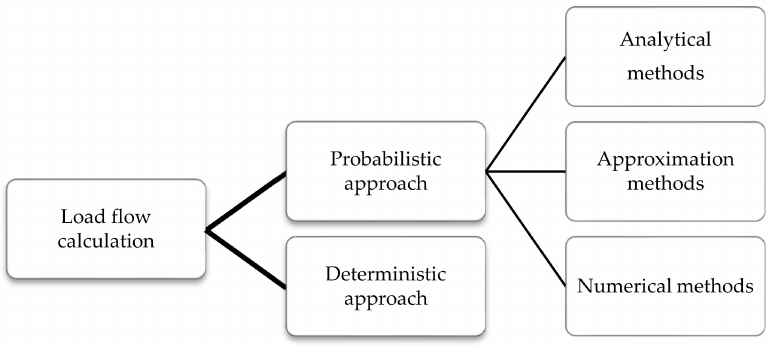
Figure 1. Load flow analysis